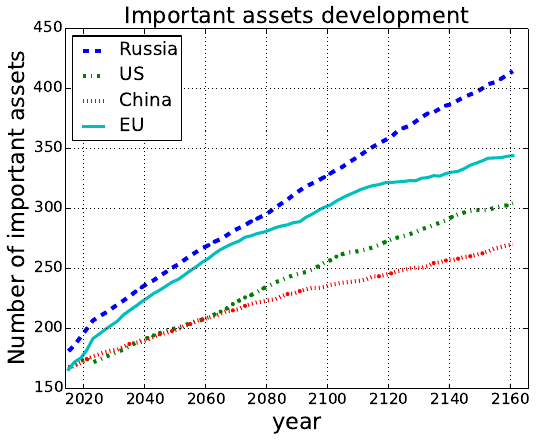
Figure 3. Important assets’